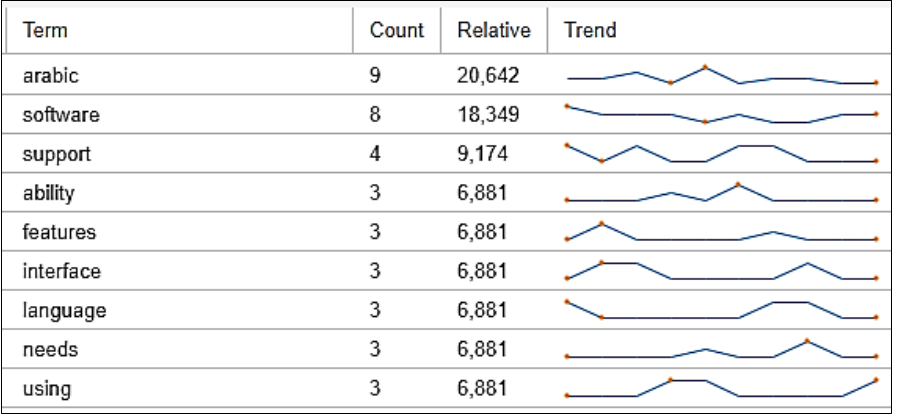
Figure 5. Most frequently used words in participants’ responses who suggested improvements for CAT.